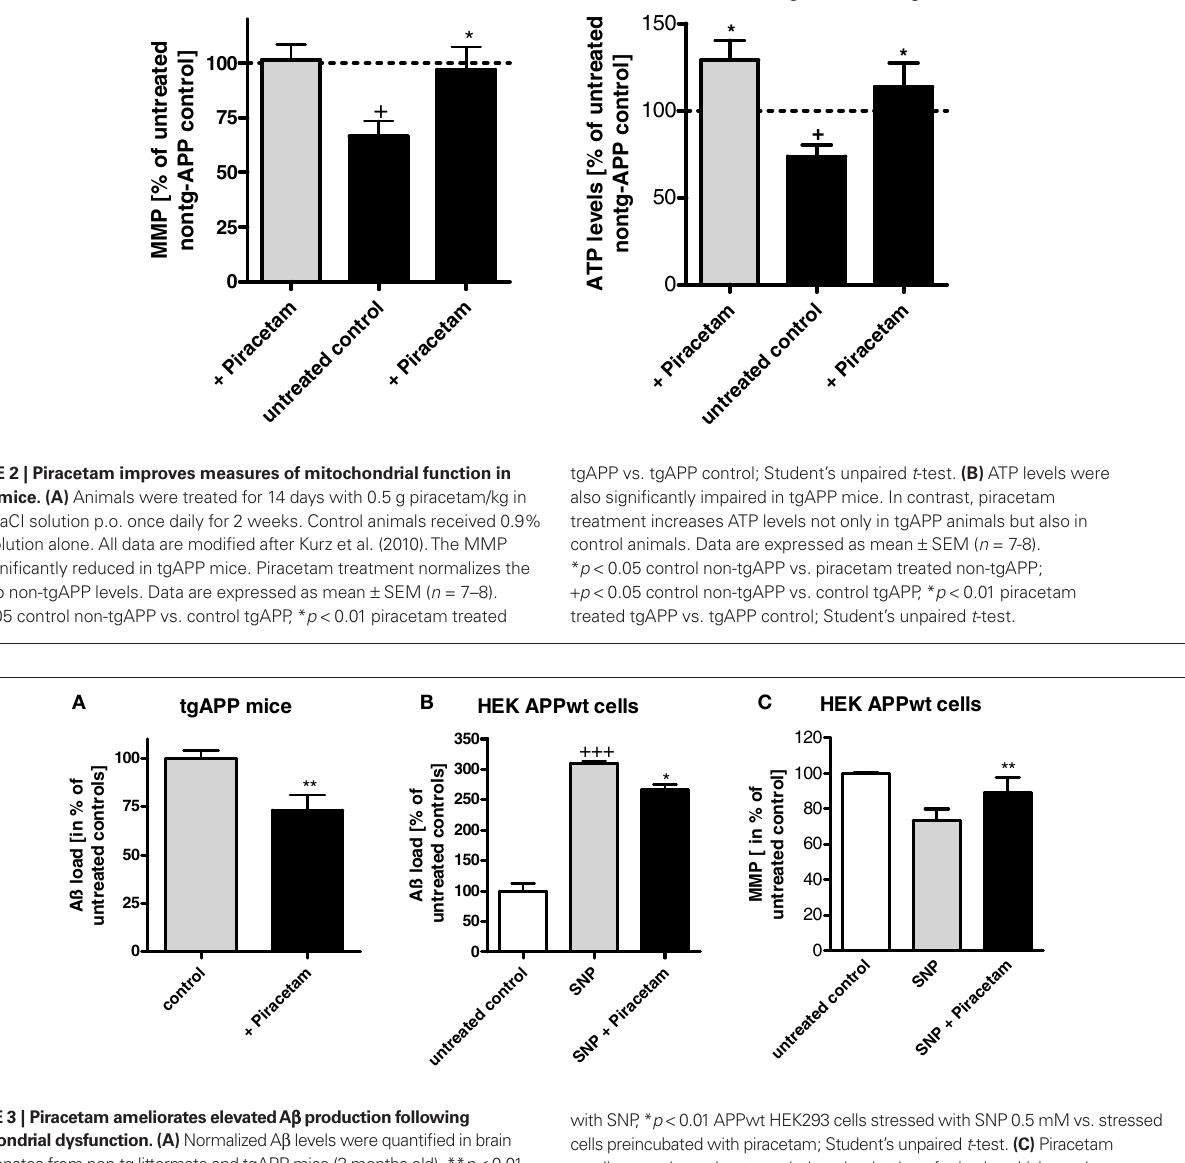
with SNP, * p < 0.01 APPwt HEK293 cells stressed with SNP 0.5 mM vs. stressed cells preincubated with piracetam; Student’s unpaired t -test. (C) Piracetam ameliorates nitrosative stress induced reduction of mitochondrial membrane potential. Cells were preincubated for 24 h with piracetam (1 mM) and stressed for additional 24 h with SNP (0.5 mM). Data are expressed as mean ± SEM ( n = 6). All data are modified after Kurz et al. (2010). ** p < 0.01 APPwt HEK293 cells stressed with SNP 0.5 mM vs. stressed cells preincubated with piracetam, Student’s unpaired t